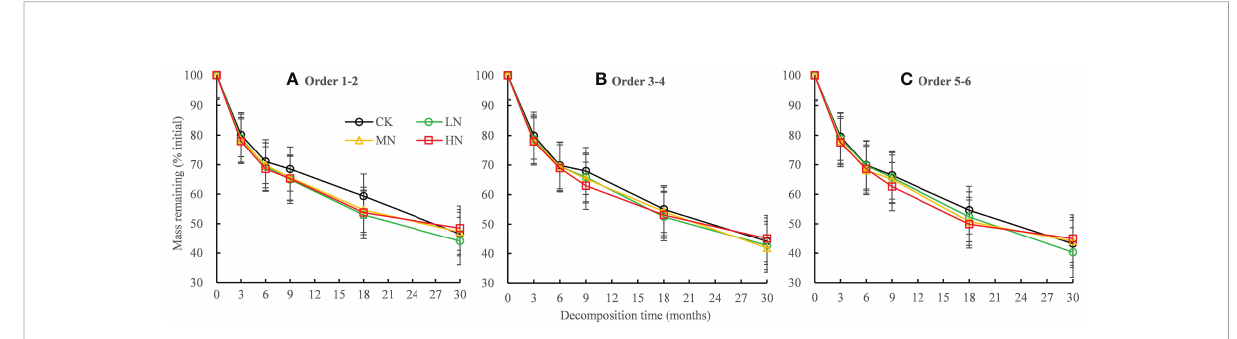
FIGURE 1 Residual percentages of the initial mass during the 30-month fi ne root decomposition of Pinus massoniana in different N addition treatments. Values are means ± SE. The different colors denote CK (0 kg ha -1 year -1 ), LN (30 kg ha -1 year -1 ), MN (60 kg ha -1 year -1 ), and HN (90 kg ha -1 year -1 ). (A – C) represent the mass remaining of order 1-2, order 3-4 and order 5-6 fi ne roots,